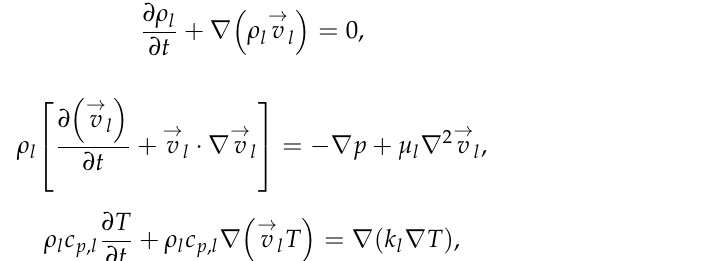
1 , T 2 , . . . T 12 ) on the battery